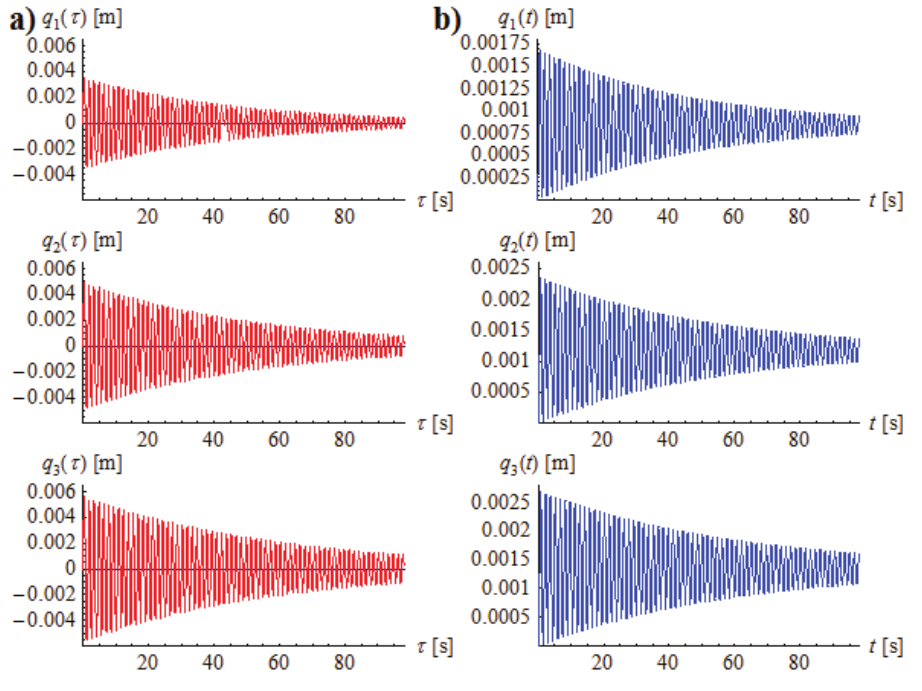
Figure 8: The results obtained from the fourth measurement: (a) displacement plots in the time domain t and (b) displacements determined in accordance with formula (7).